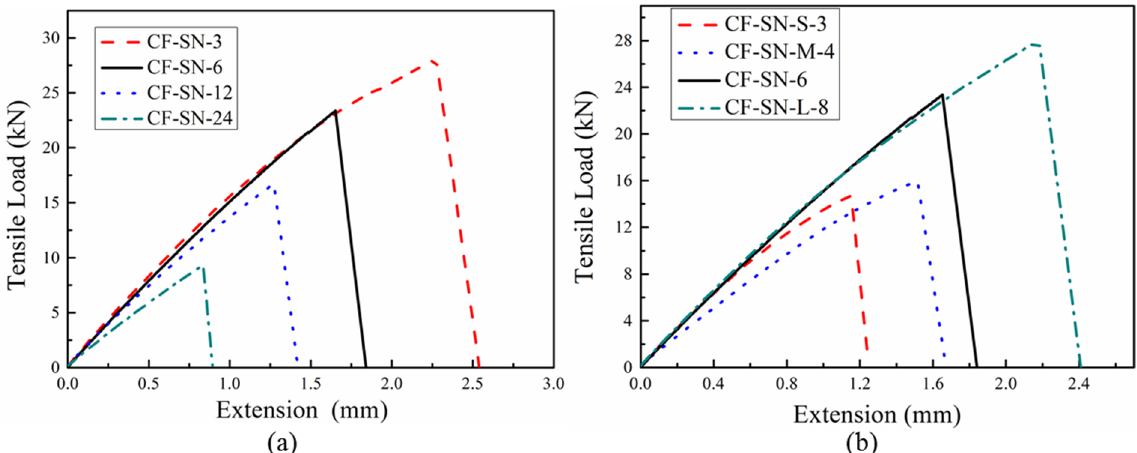
Figure 5. Load–displacement curves of straight-notched specimens under tensile load. ( a ) Equal specimen size group; when the crack length is less than or equal to 6 mm the effect of notch size on stiffness can be neglected. ( b ) Equal size ratio ( W / ( 2 C ) ) group; the stiffness of specimens in this group are not substantially affected by the size.